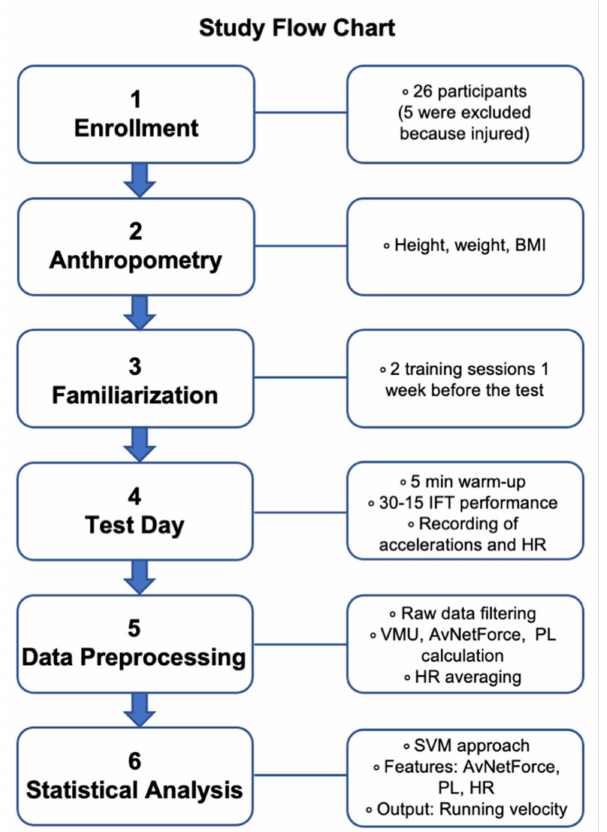
Figure 1. Study flow chart. It indicates the different experimental stages. BMI = body mass in- dex; 30–15 IFT = 30–15 intermittent fitness test; HR = heart rate; VMU = vector magnitude units; AvNetForce = average net force; PL = Player